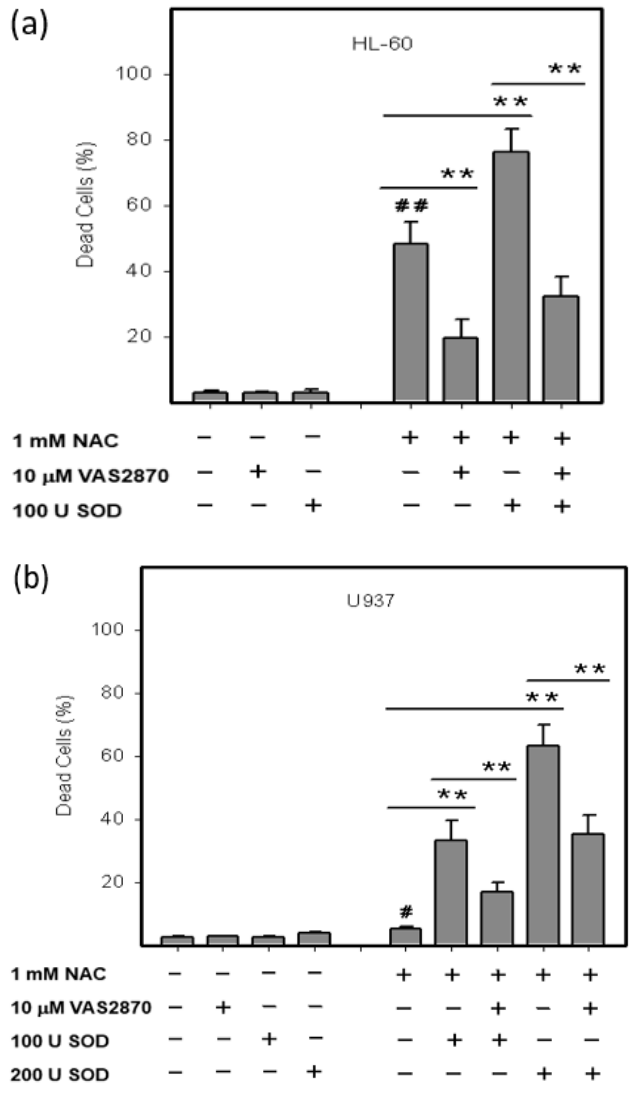
Figure 4. Effect of VAS2870 on viability of NAC treated HL-60 and U937 cells. Cells were treated with NAC in combinations with VAS2870 or with NAC in combinations with SOD and VAS2870 as indicated. After 24 h incubation, the number of dead cells was determined using the trypan blue dye exclusion assay. ( a ) HL-60 cells. ( b ) U937 cells. Columns represent the mean from three independent experiments with standard errors. # / ## denotes significant/very significant difference in the number of dead cells ( p < 0.05/ p < 0.01) between the NAC treated and untreated (control) cells. ** denotes very significant difference in the number of dead cells ( p < 0.01) between the indicated